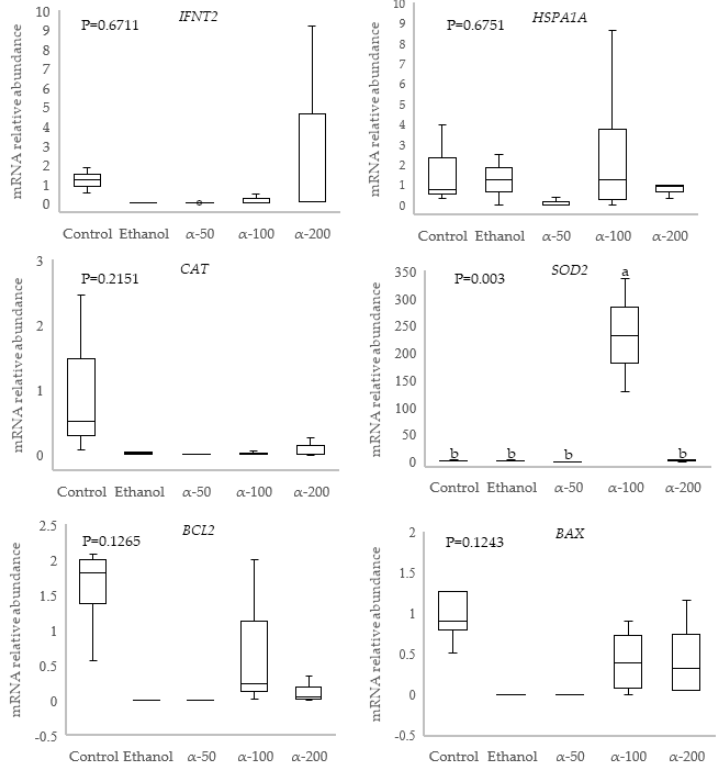
Figure 4. Effect of different concentrations of α -tocopherol during in vitro maturation of summer bovine oocytes on relative mRNA abundance of genes in expanded blastocysts of day 9 of in vitro culture. Interferon tau (IFNT2) ; Heat shock protein 70 ( HSPA1A ) ; Catalase ( CAT ); Manganese superoxide dismutase ( SOD2 ); Bcl-2-associated X protein ( BAX ); B-cell lymphoma 2 ( BCL2 ). Control: 0% ethanol and 0,0 α -tocopherol; Ethanol: 0.05% ethanol and 0,0 α -tocopherol; α -50: 50 μ M α -tocopherol; α -100: 100 μ M α -tocopherol; α -200: 200 μ M α -tocopherol. Different letters above each box represent statistically significant difference ( p < 0.05).